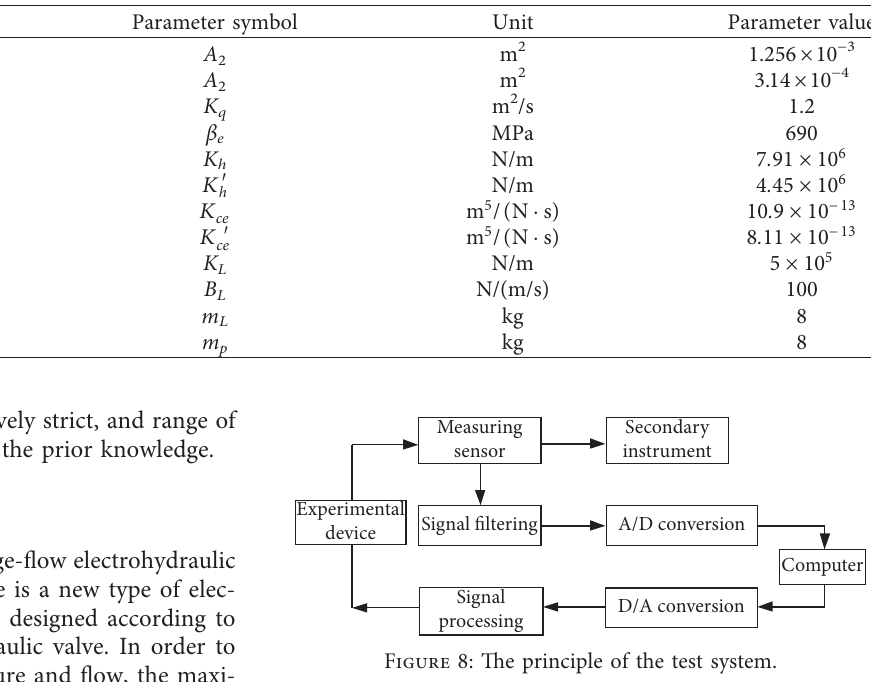
Figure 7: Two-mass connection hydraulic servo system. Table 2: Hydraulic servo system parameters.